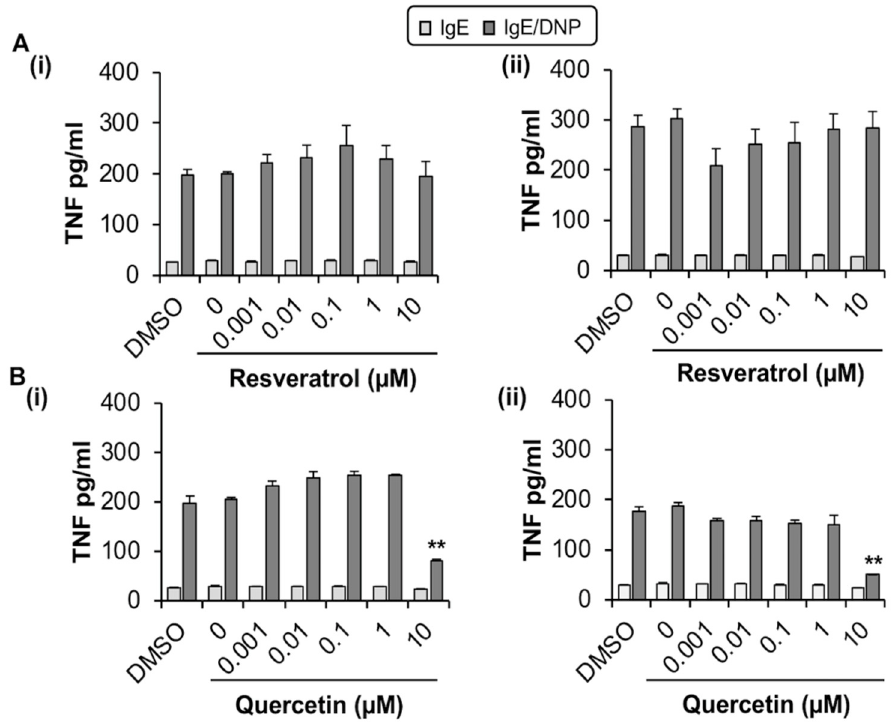
Figure 2. Effects of resveratrol ( A ) and quercetin ( B ) on TNF release by MC/9. ( A , B ) MC/9 (1X10 6 cells/mL) were sensitized with IgE and treated with resveratrol or quercetin (0–10 µM) and the DMSO control for (i) 1 h or (ii) 24 h followed by stimulation with 100 ng/mL DNP. n = 3. p value < 0.01 (**) is relative to DMSO control.